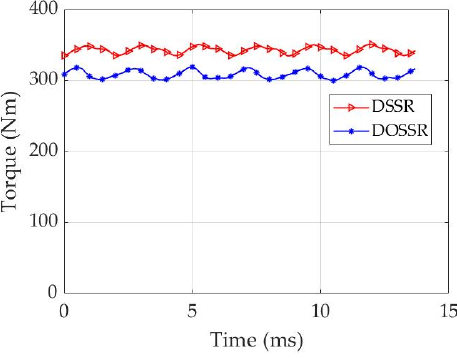
Figure 7. Torque for the DSSR motor and the DOSSR motor (100 A rms, 900 rpm).